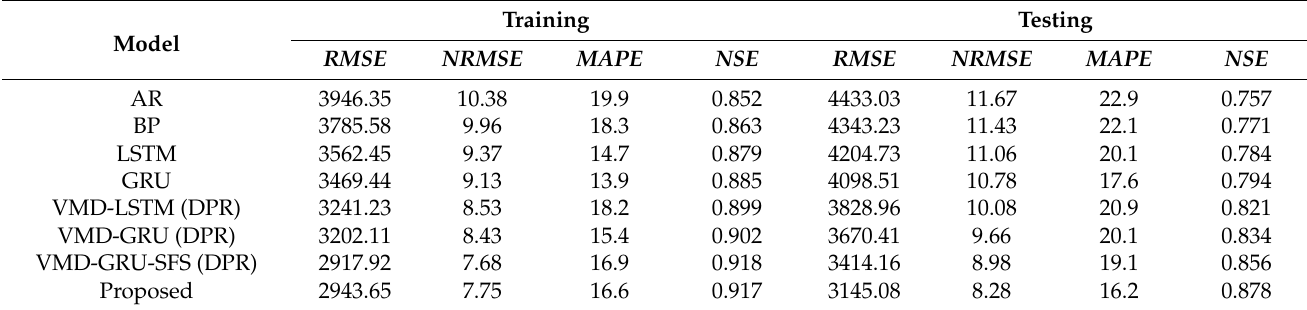
Table 4. Results of different forecasting methods for the Yichang